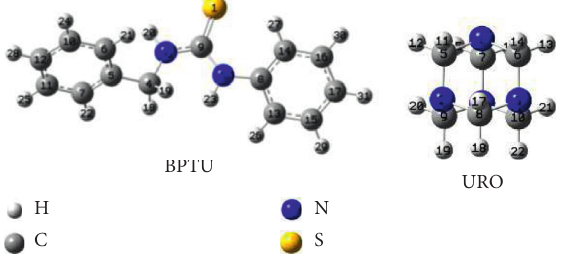
Figure 14: Optimized structures of BPTU and URO. Table 5: M¨ulliken population of BPTU in gas phase.